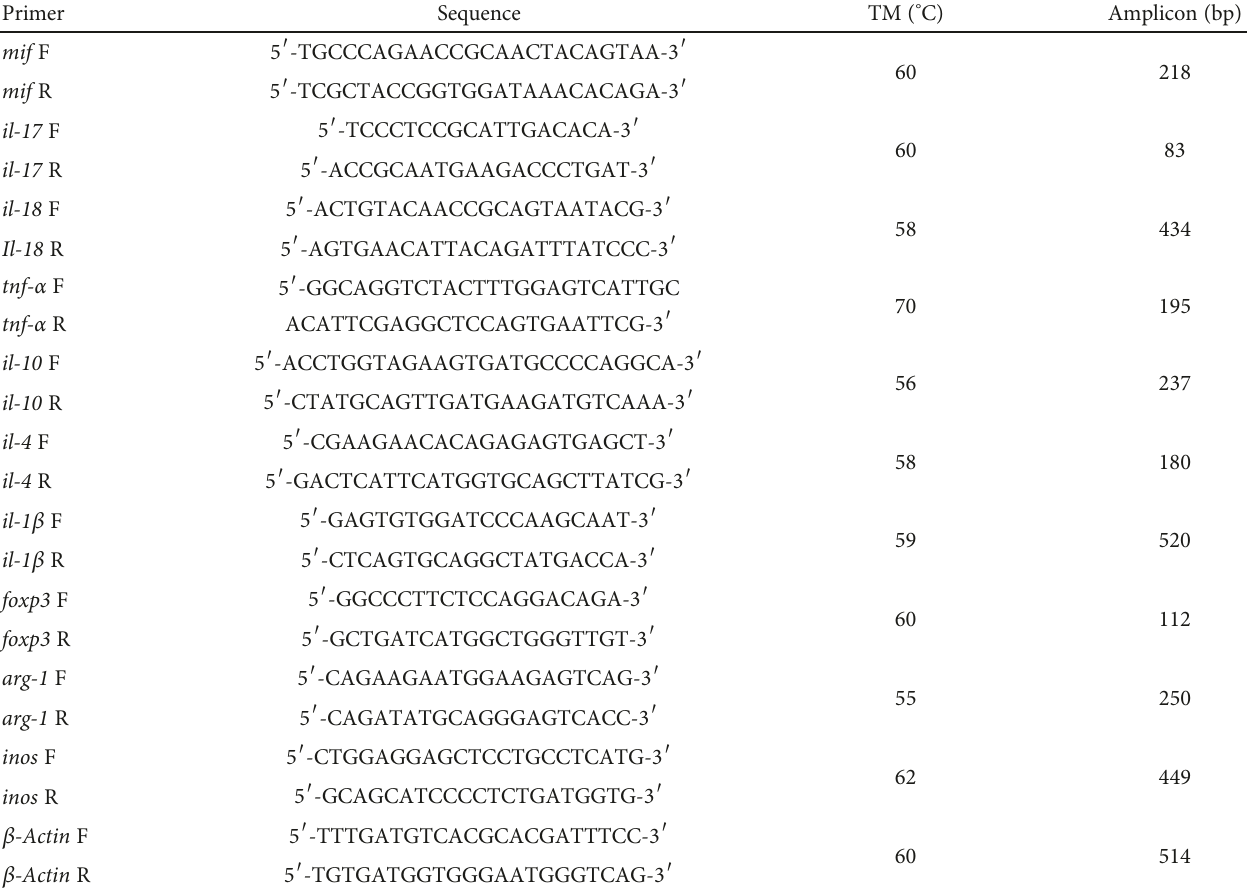
Table 1: Sequences of the primers used to determine the immune pro fi le of the tumors by endpoint RT-PCR. The TM and amplicon size are also